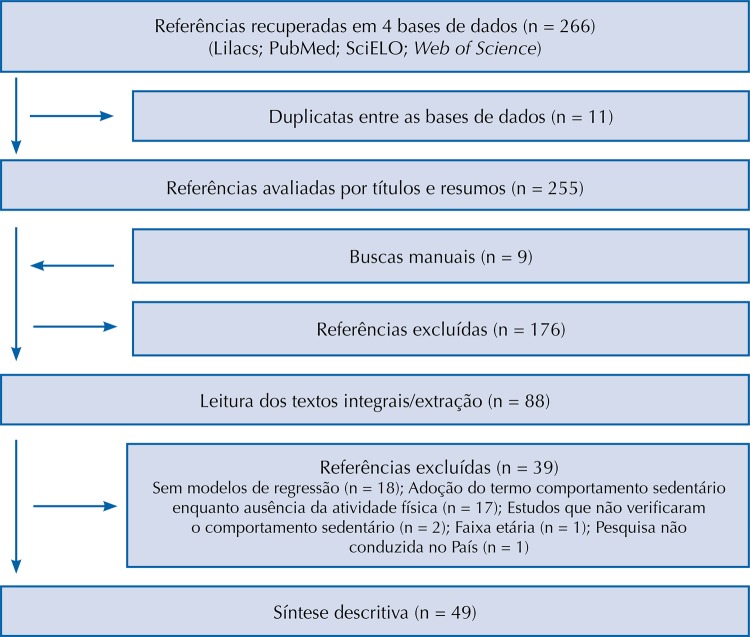
Fluxograma da revisão sistemática.